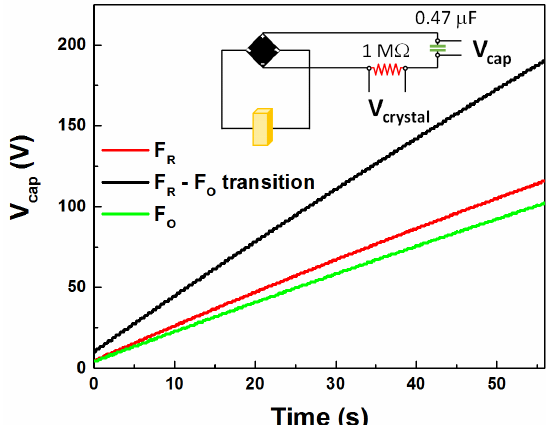
Figure 4. Voltage over a 0.47 µ F capacitor versus time when the crystal is under various pre-stress conditions. Inset shows circuit diagram used to store voltage from the piezocrystal.